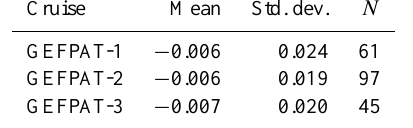
Table 3. Calibrated thermosalinograph versus water sample salinity comparison for GEF Patagonia cruises. Number of samples ( N ) is indicated for each cruise. Std.